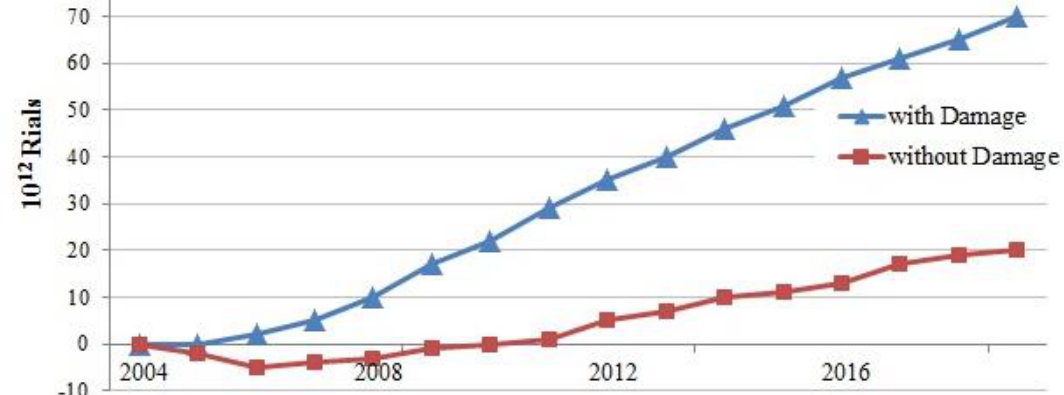
Figure 4. Cumulative net benefits to the country (10 12 Rials)